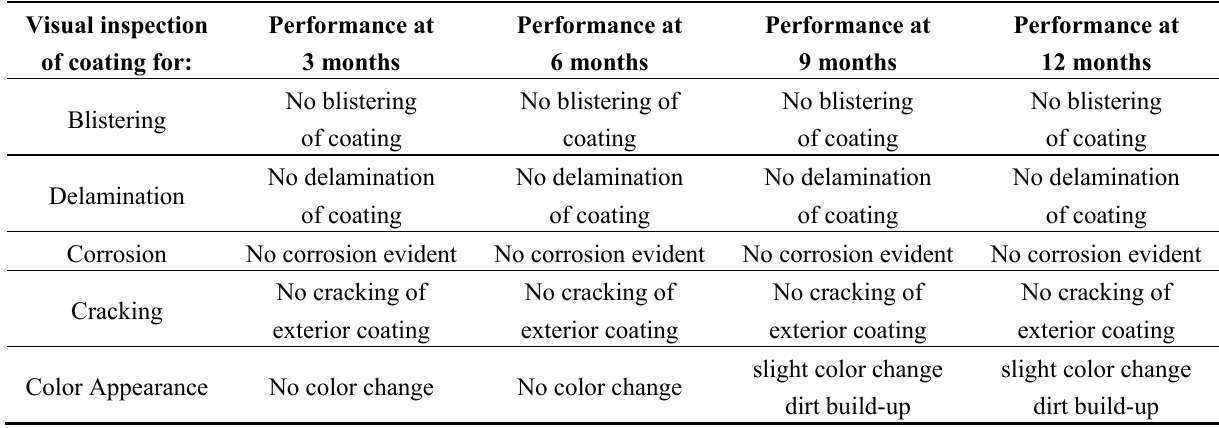
Table 5. Assessment of BAM-PPV field test on air force C-5 cargo plane rear hatch door. Visual